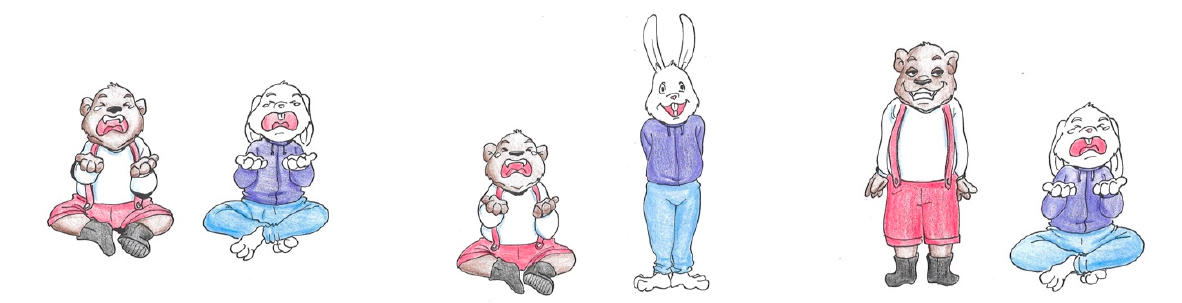
Figure A44. Filler stimulus 19. El conejo manda al mono a nadar, y lo hace.